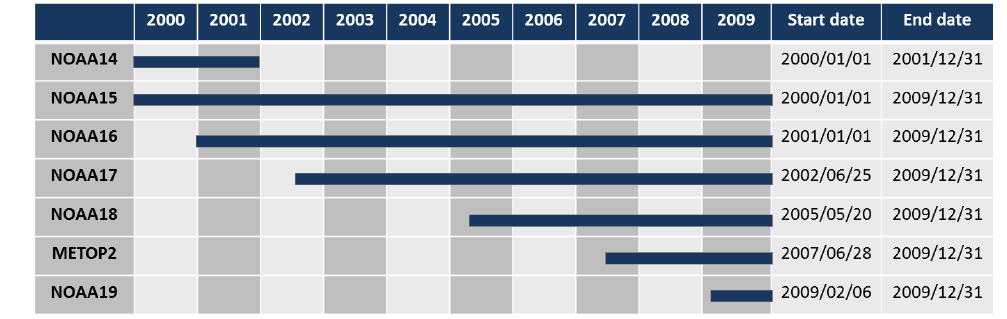
Figure 2. NOAA and Metop satellites carrying the AVHRR sensor, used for AASTI version